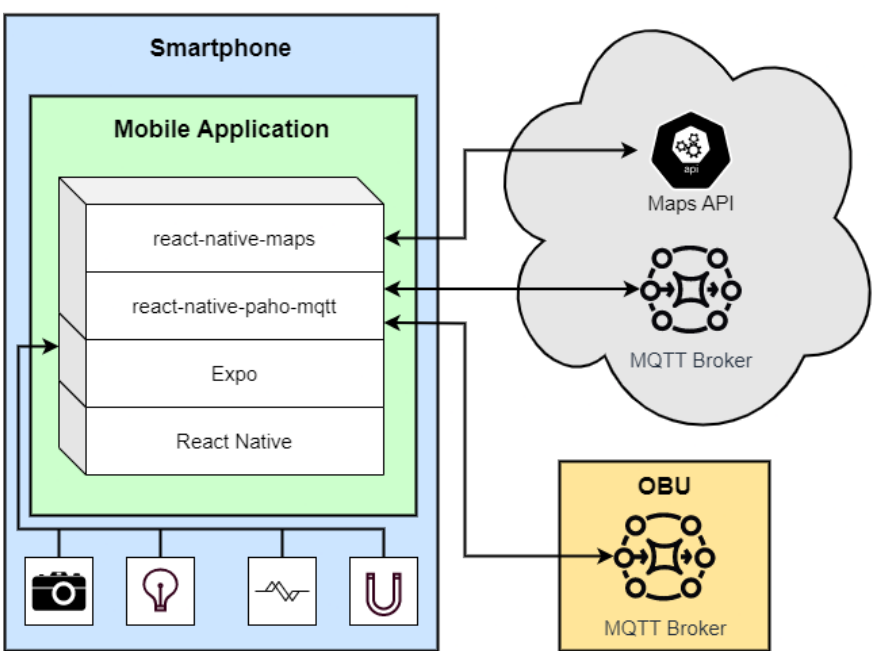
Figure 6. Diagram of the mobile application